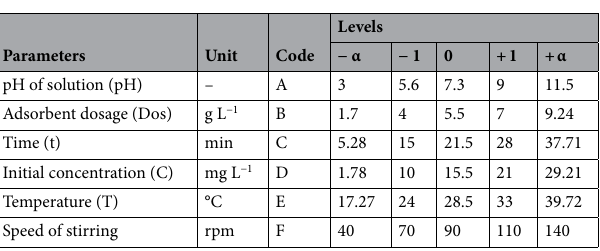
Table 1. Independent variables, their units and codes for the CCD